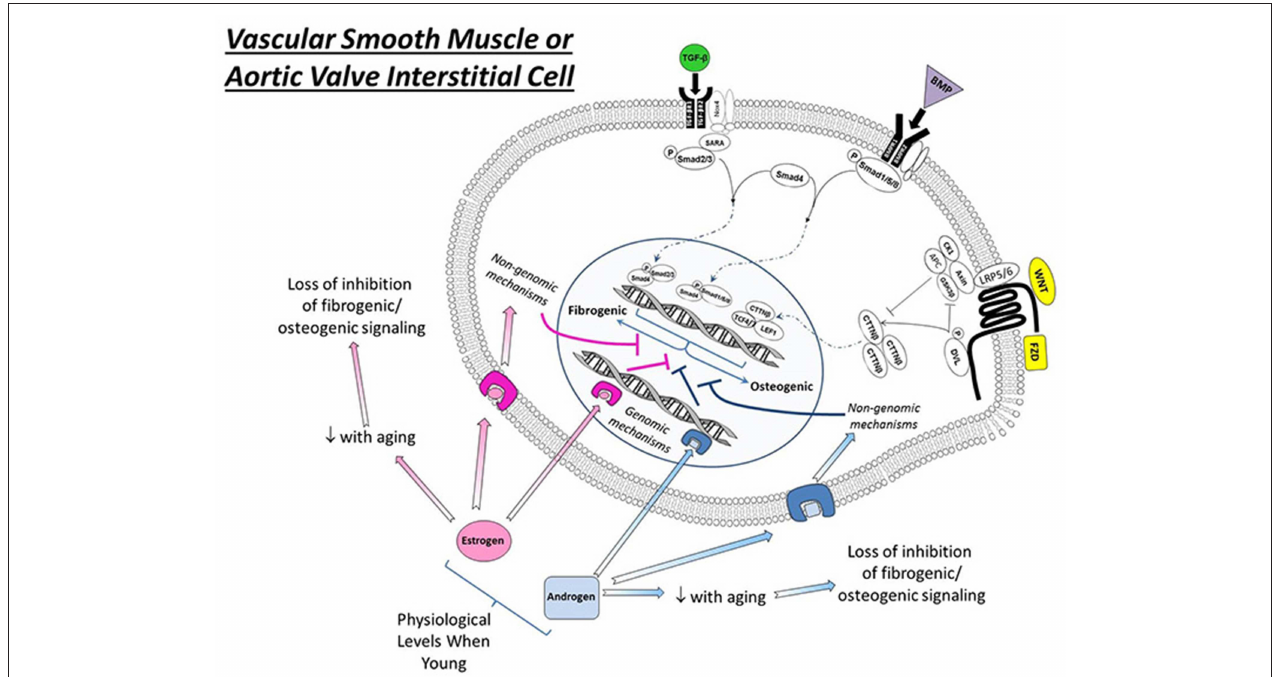
FIGURE 1 | Effects of estrogens and androgen signaling on multiple cellular processes implicated in the regulation of cardiovascular calcification. Note that estrogen can bind to estrogen receptors (ER, resulting in nuclear translation), G-protein coupled estrogen receptors (GPER, eliciting cytosolic signaling), and estrogen binding proteins (EBPs, eliciting cytosolic signaling) to exert a variety of effects—both positive and negative—on molecules influencing ectopic calcification. In general, androgens bind to androgen receptors (AR) and have a smaller number of signal transducing elements compared to estrogens. Abbreviations and impact on calcification: RANKL, receptor activator of nuclear factor κ B ligand (promotes calcification); PPAR γ , peroxisome proliferator-activated receptor- γ (prevents calcification); NF κ B, nuclear factor κ B (promotes inflammation/calcification); NADPH oxidase, nicotinamide adenine dinucleotide phosphate oxidase